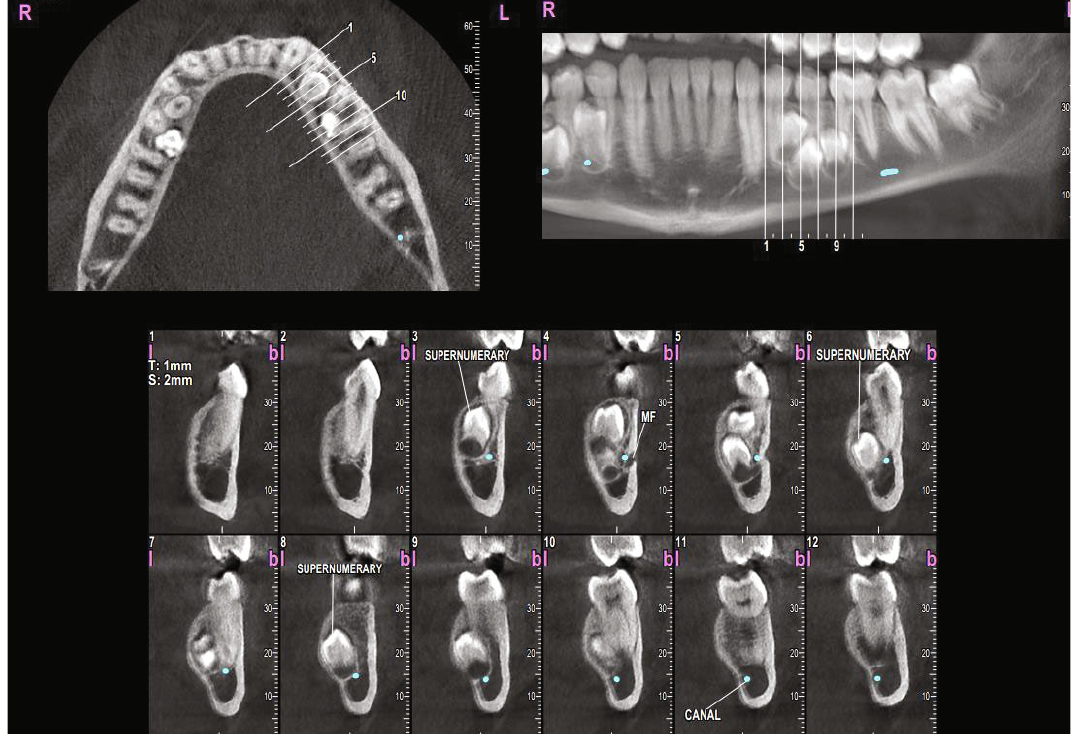
Figure 8: Vertical sections perpendicular to the alveolar ridge, showing the position and morphology of supernumerary teeth in the mandibular left